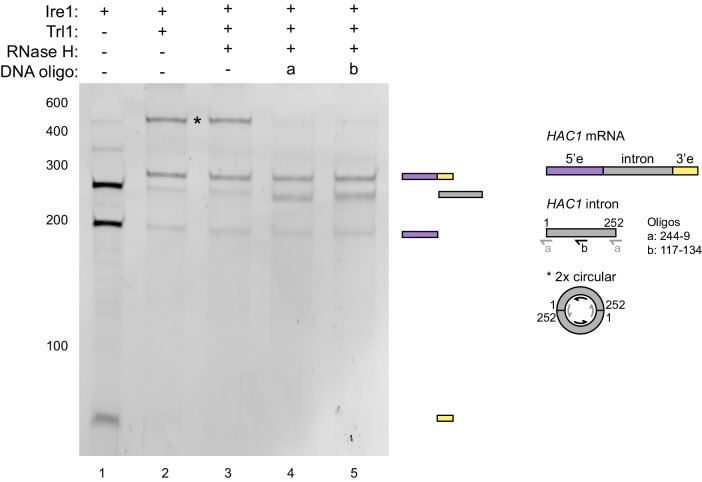
RNase H assay.In vitro transcribed HAC1U-508 RNA was cleaved by Ire1 (lane 1) and subsequently ligated by Trl1 (lane 2). The ligation products were hybridized with DNA oligonucleotides a (lane 4) or b (lane 5) and treated with RNase H. In lane 3, no oligonucleotide was added. The RNA products after each step were analyzed on a denaturing polyacrylamide gel and visualized by SYBR Gold staining. The band in question (marked with an asterisk) disappeared upon RNase H digestion of the RNA/DNA hybrids and a band at the position of the severed intron (252 nt) reappeared. Based on this result and the position on the gel, the marked band represents most likely two introns that were circularized by two intermolecular ligation events at their 5’ and 3’ ends. Hybridization positions of the DNA oligonucleotides on a linear HAC1 intron and the putative circular concatemer of two introns are schematically described in the right.